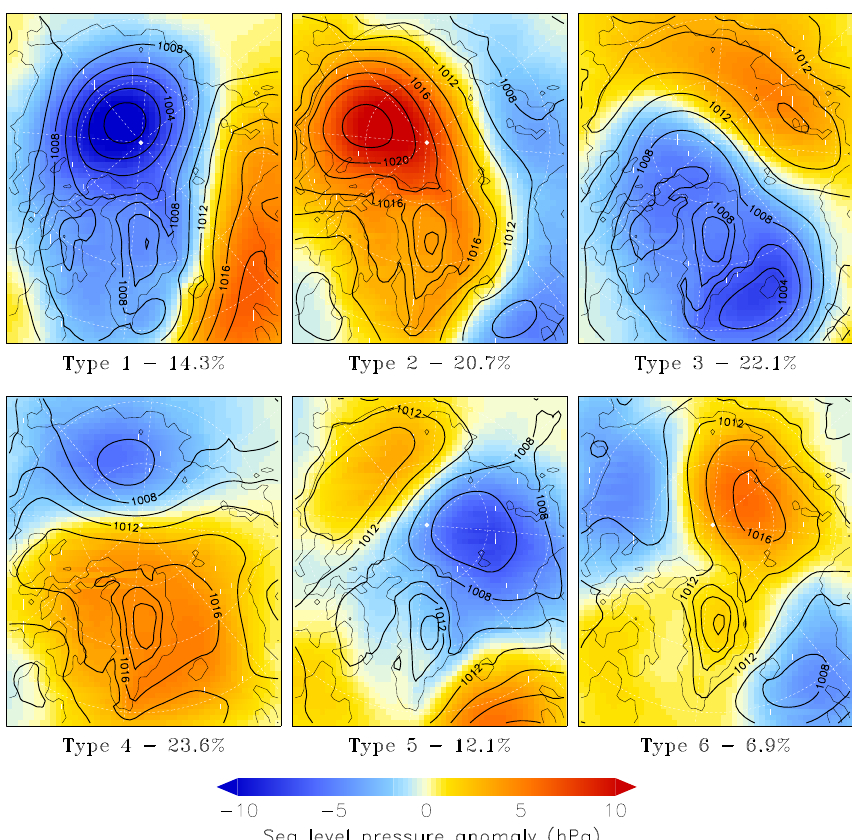
Figure 1. The SLP-based reference circulation types over the 1980–2012 (JJA) period for the ERA-Interim are represented by the solid black isobars (in hPa). The SLP anomaly (in colours) is calculated as the difference between the class mean SLP and the seasonal mean SLP over 1980–2012. The average frequency of each type is also